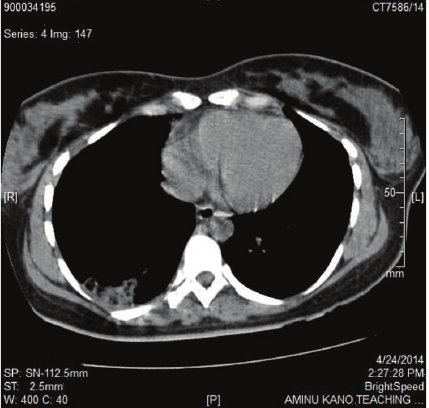
Figure 2: Chest CT scan showing consolidation with “cavities” in the right posterior lung